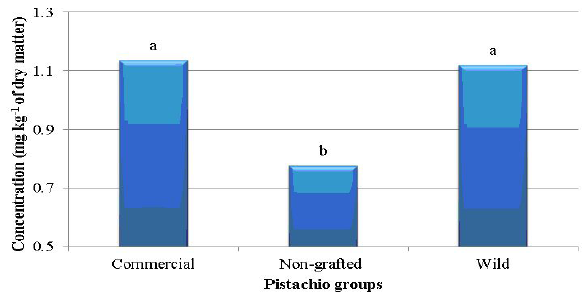
Fig. 4. The chromium concentration of three Iranian pistachio groups. (Each column with different letters is significantly dif- ferent (P < 0.05)